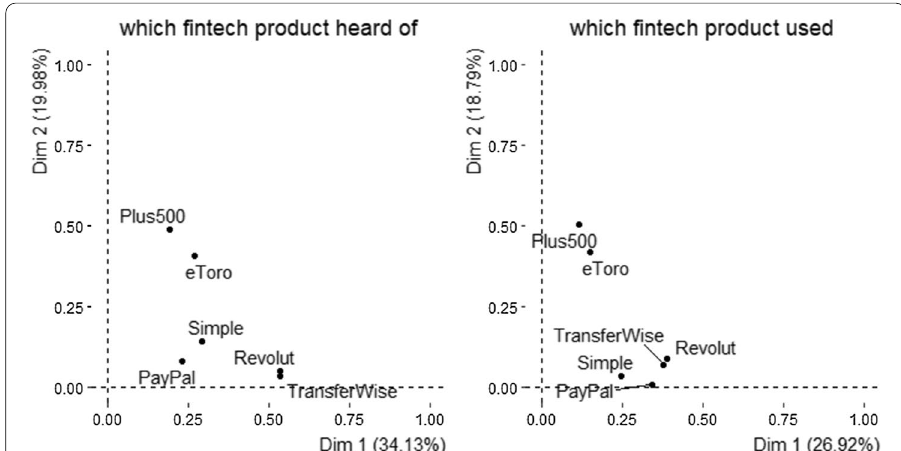
Fig. 7 MCA analysis of knowledge of and experience with fintech